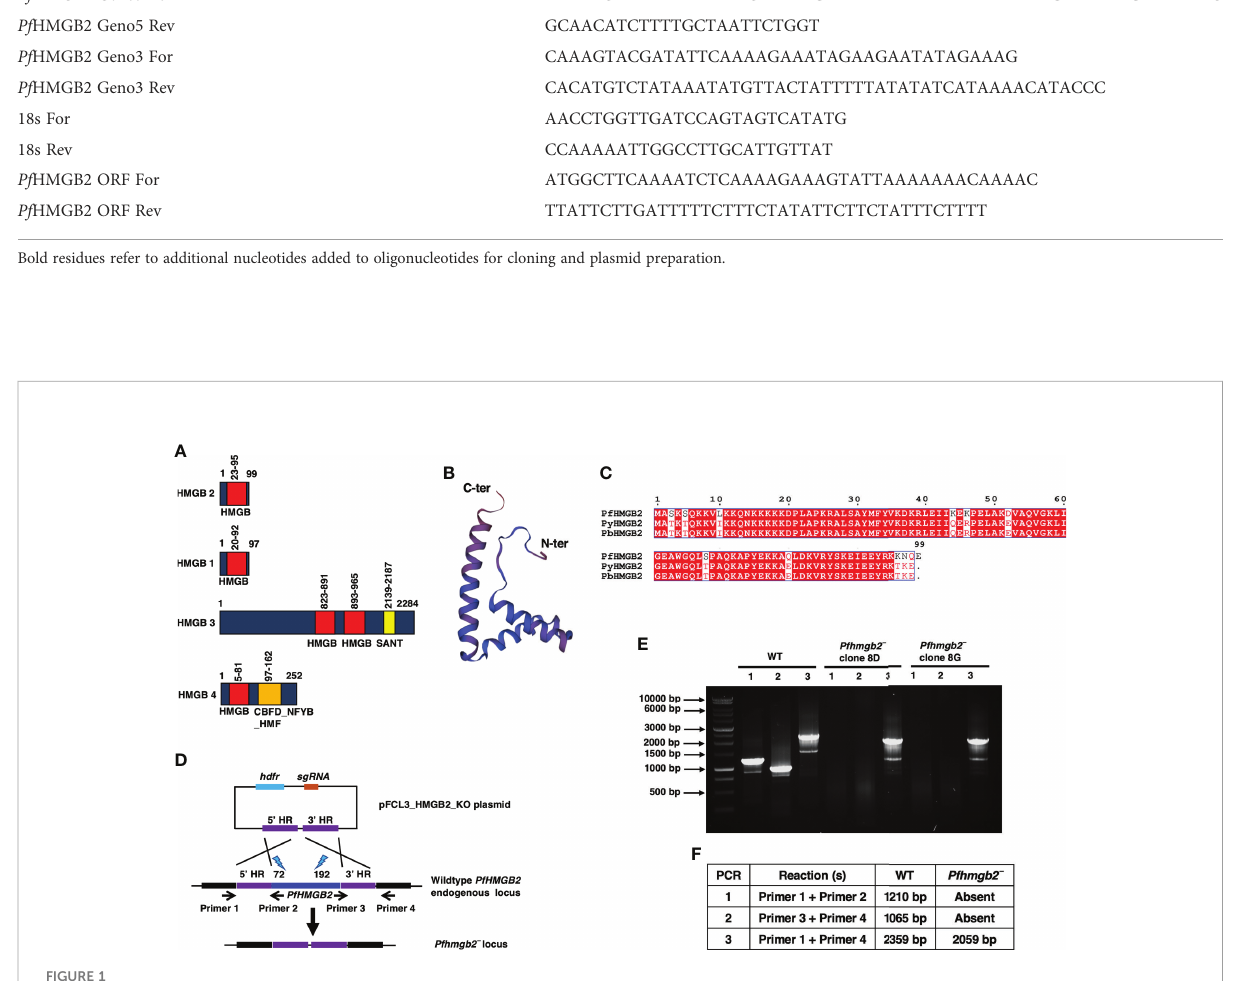
FIGURE 1 Pf HMGB2 structural features and generation of Pfhmgb2¯ parasites via CRISPR/Cas9. (A) Schematic for the Pf HMGB2, Pf HMGB1, Pf HMGB3 and Pf HMGB4 proteins. Pf HMGB2, Pf HMGB1 and Pf HMGB4 have a single HMG box (red bar) domain while Pf HMGB3 has two. Pf HMGB3 and Pf HMGB4 also contain additional domains; SANT domain in Pf HMGB3 (yellow bar) and CBFD_NFYB:HMF domain in Pf HMGB4. (B) Predicted three-dimensional structure of Pf HMGB2. PDB template used 2mrc.1.A. The N and C terminus are indicated. (C) Sequence alignment for Pf HMGB2, Py HMGB2 and Pb HMGB2. Conserved residues are in white font on a red background. Pf - Plasmodium falciparum , Py - Plasmodium yoelii , Pb - Plasmodium berghei . (D) The schematic shows the strategy for disrupting the PfHMGB2 gene. pFCL3_HMGB2_KO plasmids has homology regions from 5 ’ (5 ’ HR) and 3 ’ (3 ’ HR) of PfHMGB2 locus, single guide RNA sequence (sgRNA) and human dihydrofolate reductase (hDHFR) locus cloned. Lightning bolts and numbers next to them indicate target site of gRNAs. (E) Diagnostic PCR for the con fi rmation of PfHMGB2 deletion. The oligonucleotides were designed from outside 5 ’ HR and 3 ’ HR and PfHMGB2 locus and positions are indicated by arrows in (D) . (F) The expected sizes for different set of PCRs are